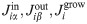
Constructing the dynamical law.The MicroCRM models the growth and metabolism of S microbial species in terms of energy fluxes Jiαin,Jiβout,Jigrow, mediated by import, export and chemical transformation of M substitutable resources. Specification of the resource dynamics and of the dependence of import rates on the resource concentrations requires three additional modeling choices, represented by the three arrows. First, the intrinsic dynamics of the resources can either be a linear model of a fixed external input flux and dilution rate, or a logistic model of self-renewing resources, which was employed in MacArthur’s original CRM. The left-hand plot shows the supply rate as a function of resource concentration for these two options. Second, the import rates from the different resource types can be independent, or globally regulated in such a way as to preferentially consume the resource that is currently most abundant. The middle plot shows timeseries of consumer and resource abundances in the presence and absence of regulation, with all other parameters held fixed. Third, the dependence of import rates on resource concentration can take a linear (Type-I), Monod (Type-II) or Hill (Type-III) form. The right-hand plot shows the growth rate as a function of resource concentration for these three choices.